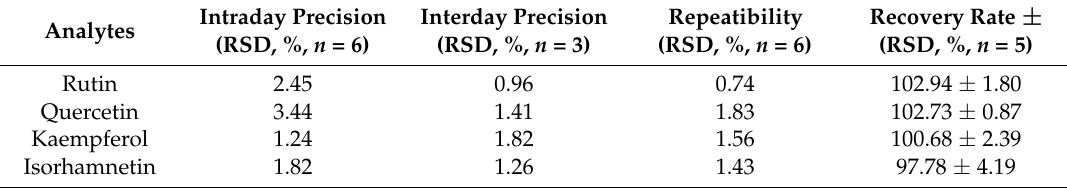
Table 4. Precision, repeatability, and recovery rate of four flavonoids in Flos